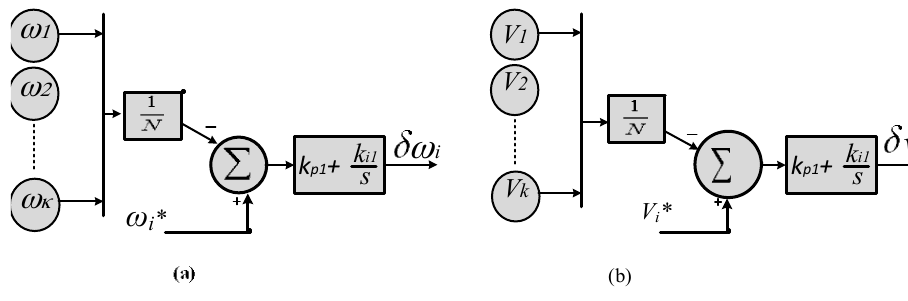
Figure 5. ( a ) Frequency regulation; ( b ) voltage regulation.